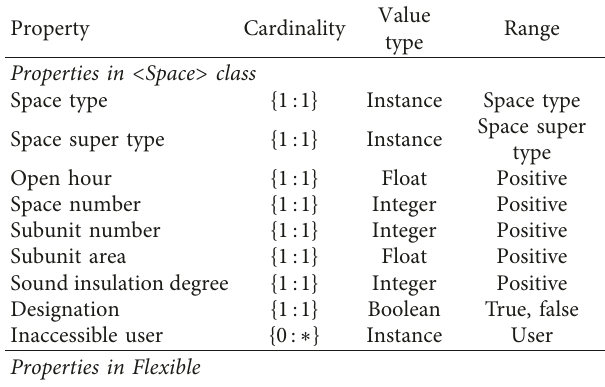
Table 2: Properties and Facets of the < Space > , < Whole room use > , and < Equipment use >